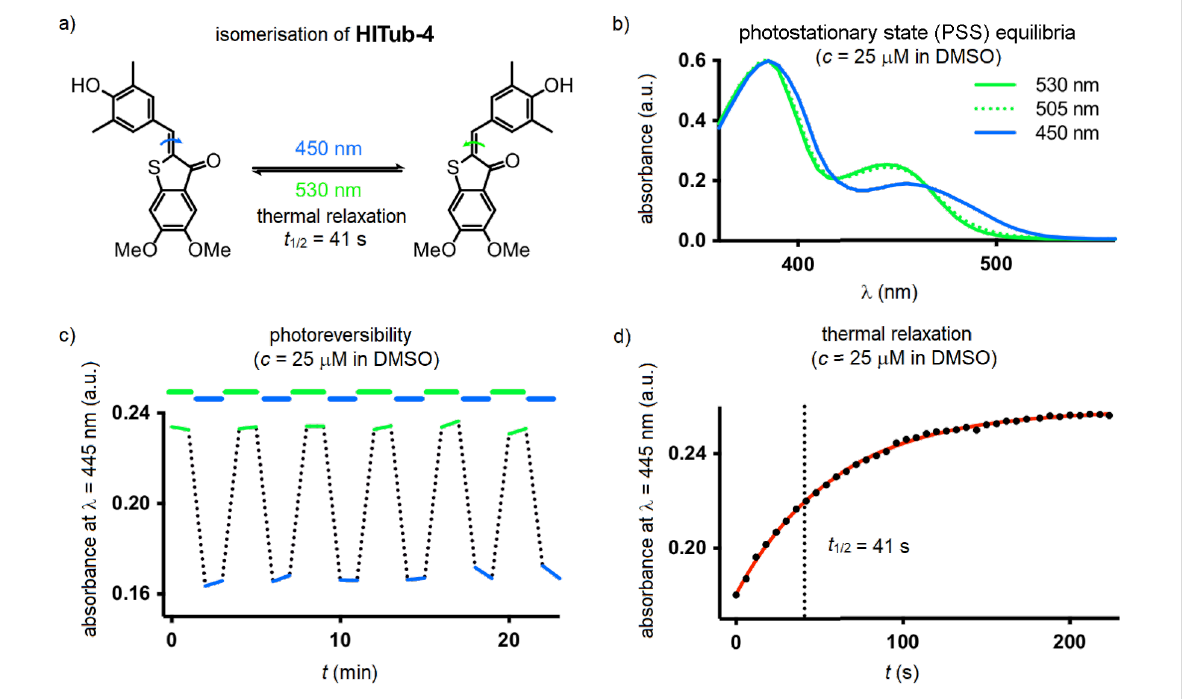
Figure 3: Photocharacterisation of HITub-4 . a) Photochemical and thermal isomerisation. b) UV–vis spectra after saturating illumination at λ = 450, 505, and 530 nm, respectively. c) Photoreversible switching upon alternating illumination ( λ = 450 and 530 nm). d) Thermal relaxation at room temper- ature after reaching the photostationary state at λ = 450